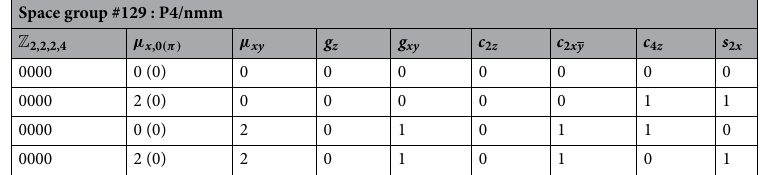
Table 1. Possible topological crystalline phases corresponding to the trivial 3 Z 2 ( ν 1 ν 2 ν 3 ν 4 ) = (0,0,0,0) in space group #129. µ i and g i and c i , and s i are the mirror and glide and rotation and screw-resolved topological invariants about the i -invariant plane and the i -axis, respectively ( i = x , xy , · · · ). We have applied the results of Ref. 66